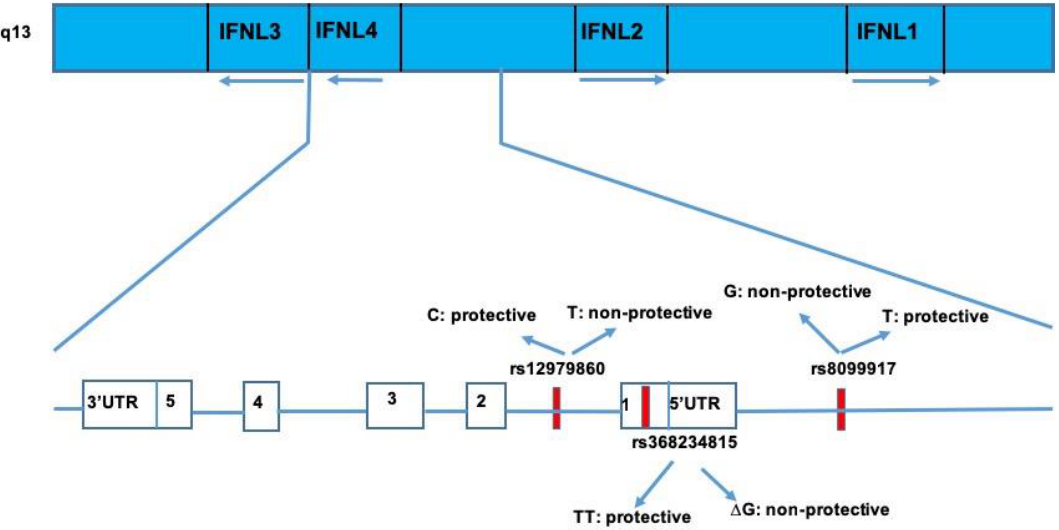
Figure 2. Representation of the interferon lamda 3-4 (IFNL) locus and IFN 1 and two loci in chromosome 19q13 with key single nucleotide polymorphisms (SNPs) involved in clearance of HCV